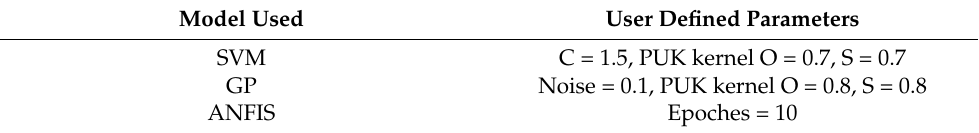
Table 8. Use Defined Parameters.